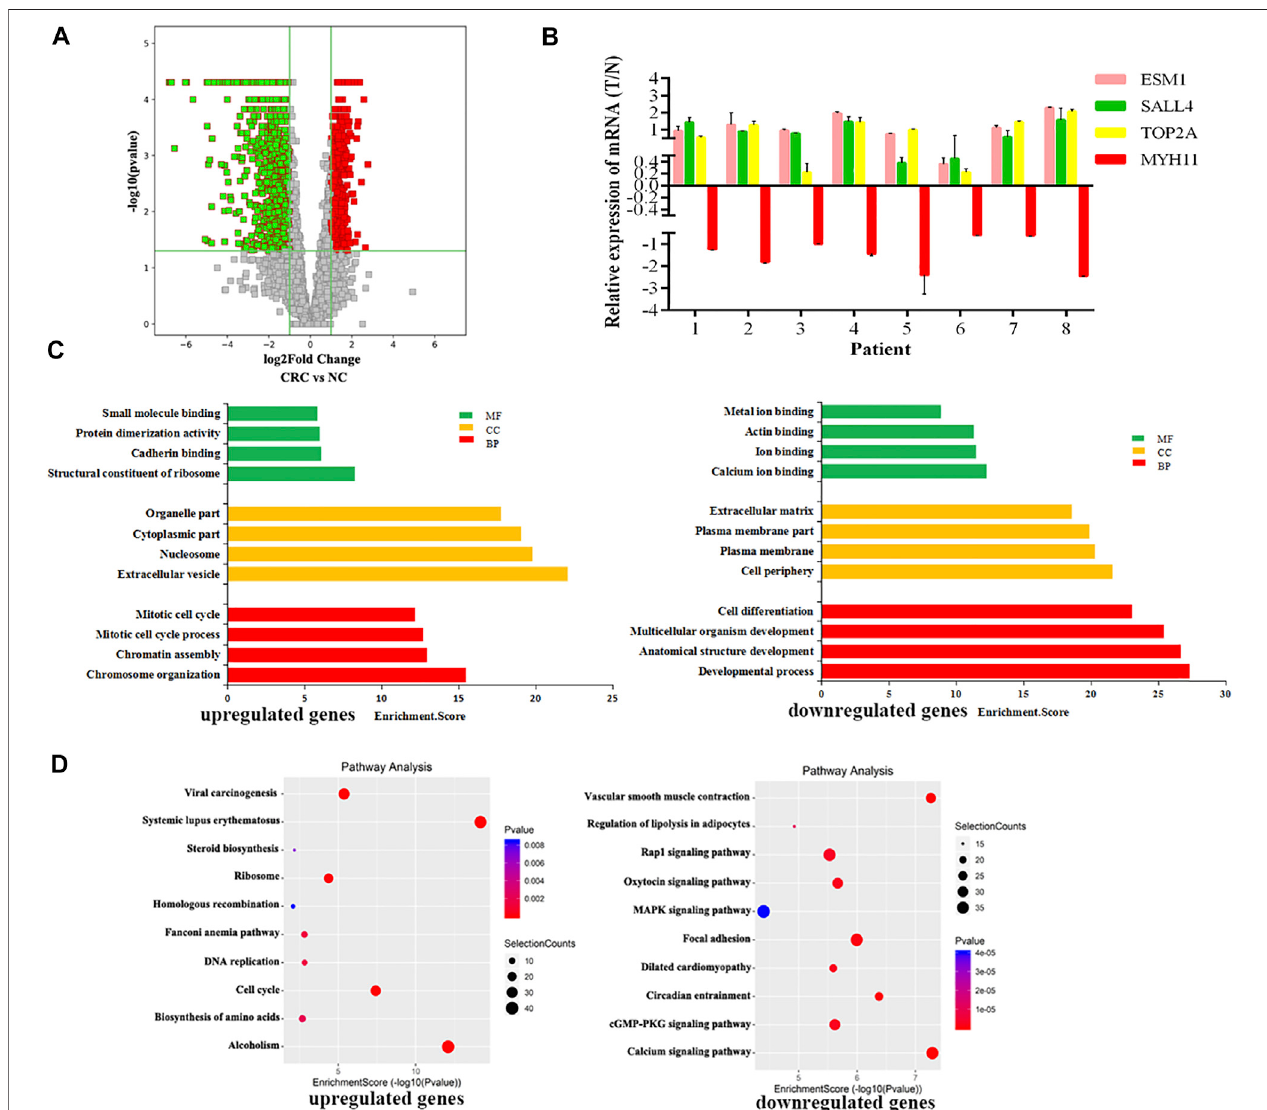
FIGURE 3 | Identi fi cation of differentially expressed genes (DEGs) in CRC by RNA-seq. (A) The volcano plot showing the DEGs in CRC and NC groups. (B) The results of qRT-PCR for ESM1, SALL4, TOP2A, MYH11. (C) The top 10 GO terms signi fi cantily enriched for the upregulated genes on the left and downregulated genes on the right. (D) The top 10 GO terms signi fi cantly enriched for the upregulated genes on the left and downregulated genes on the right.